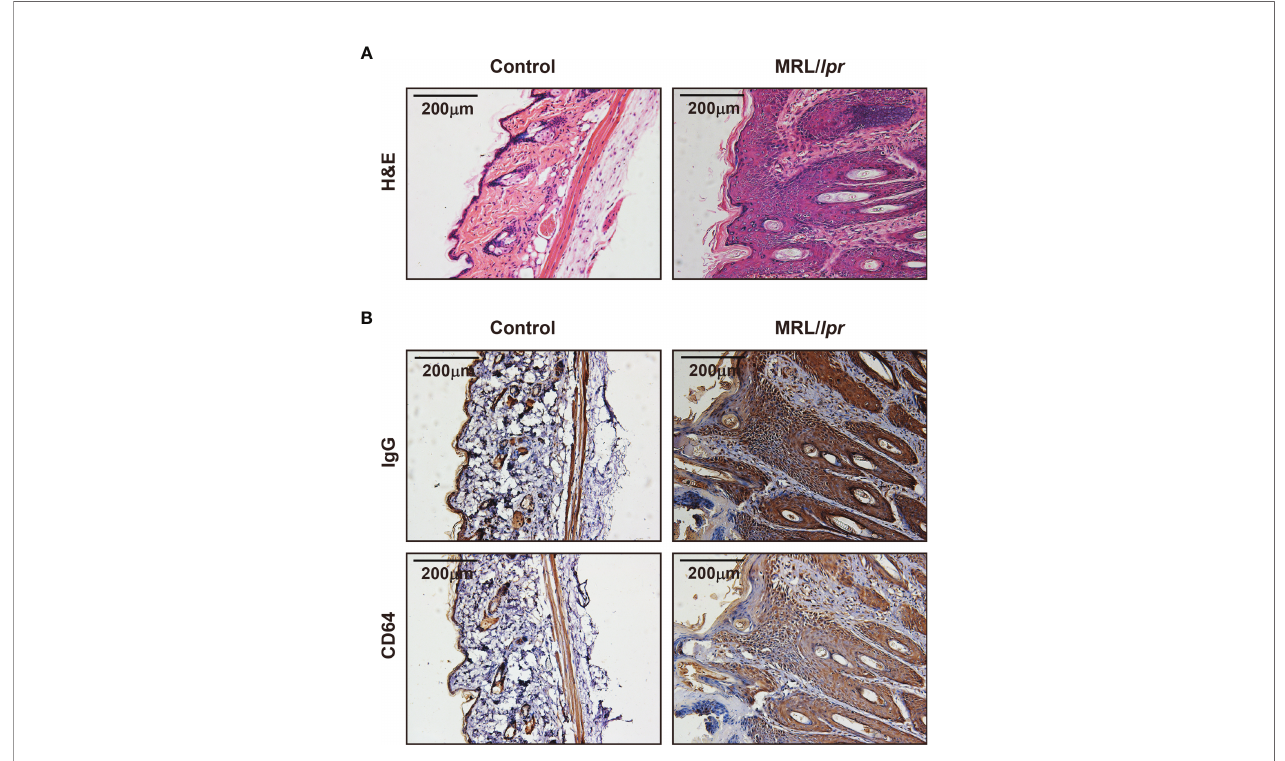
FIGURE 3 | CD64 markedly increased in skin damages in MRL/ lpr mice. (A) Representative photograph of H&E staining skin in fl ammation of female 30-week-old MRL/ lpr mice and normal C57BL/6 mice. (B) Representative photograph of IgG and CD64 deposition stained by immunohistochemistry in skins of female 30-week- old MRL/ lpr mice and normal C57BL/6